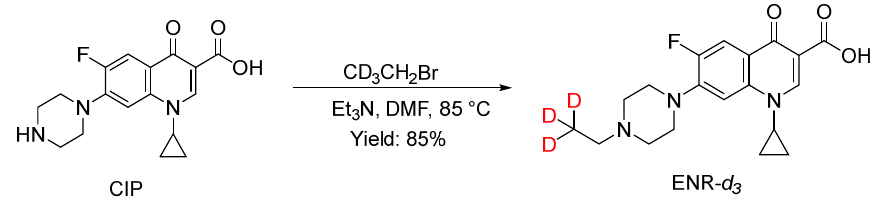
Figure 2. Synthetic route for the target compound.